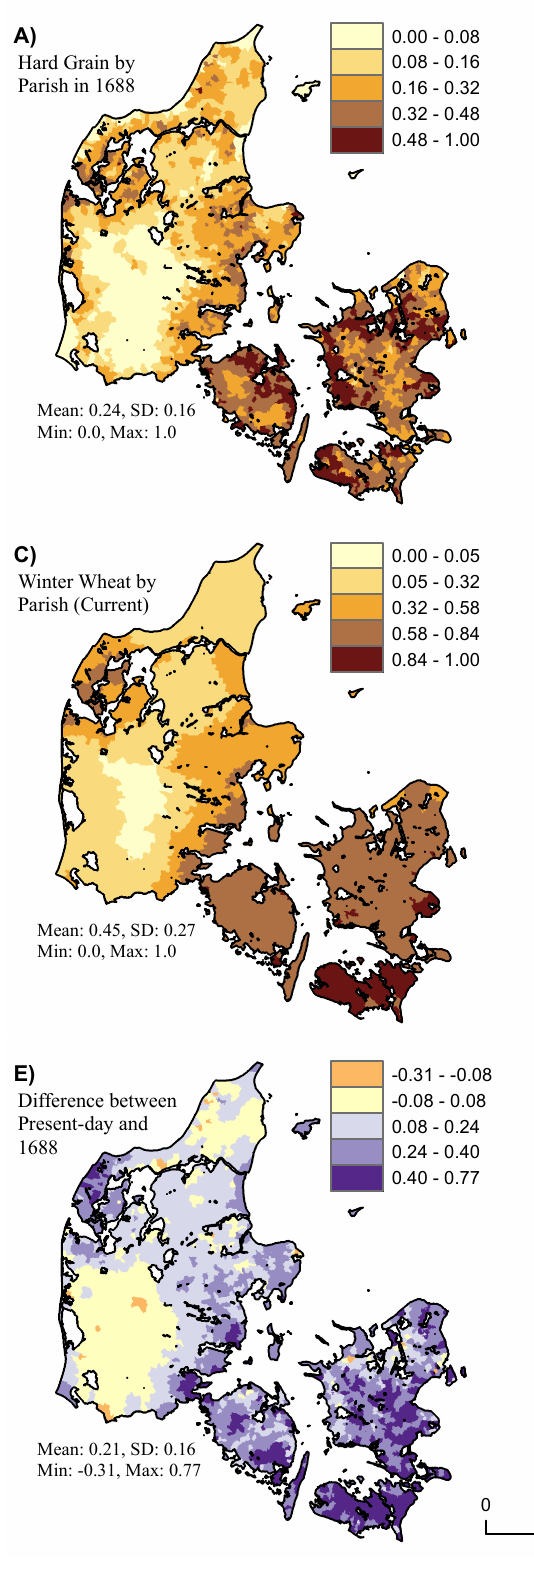
Figure 5. The three time periods compared by parish. ( A – C ) Normalized values for hard grain in 1688, 1844, and current winter wheat yield, respectively. ( D – F ) Differences between each time